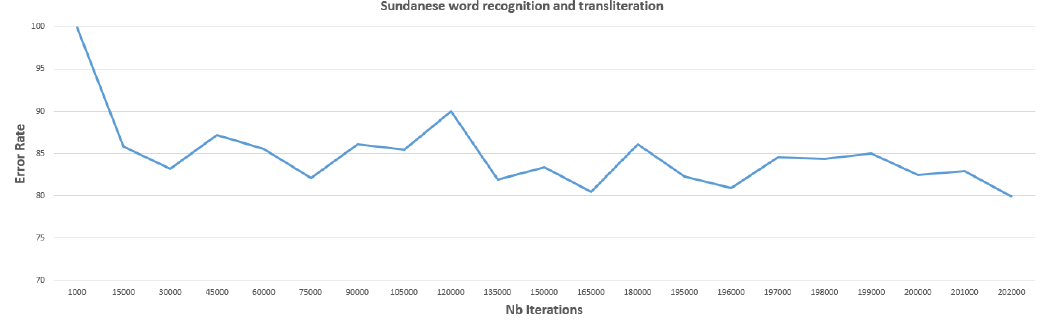
Figure 28. Error rate for Sundanese word recognition and transliteration test set.